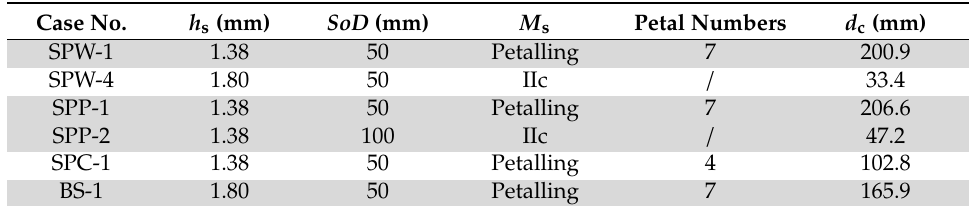
Table 5. Measurements of crevasses / holes of front steel layers in polyurea-coated steel plates and a bare steel plate, BS-1 (from Ref.